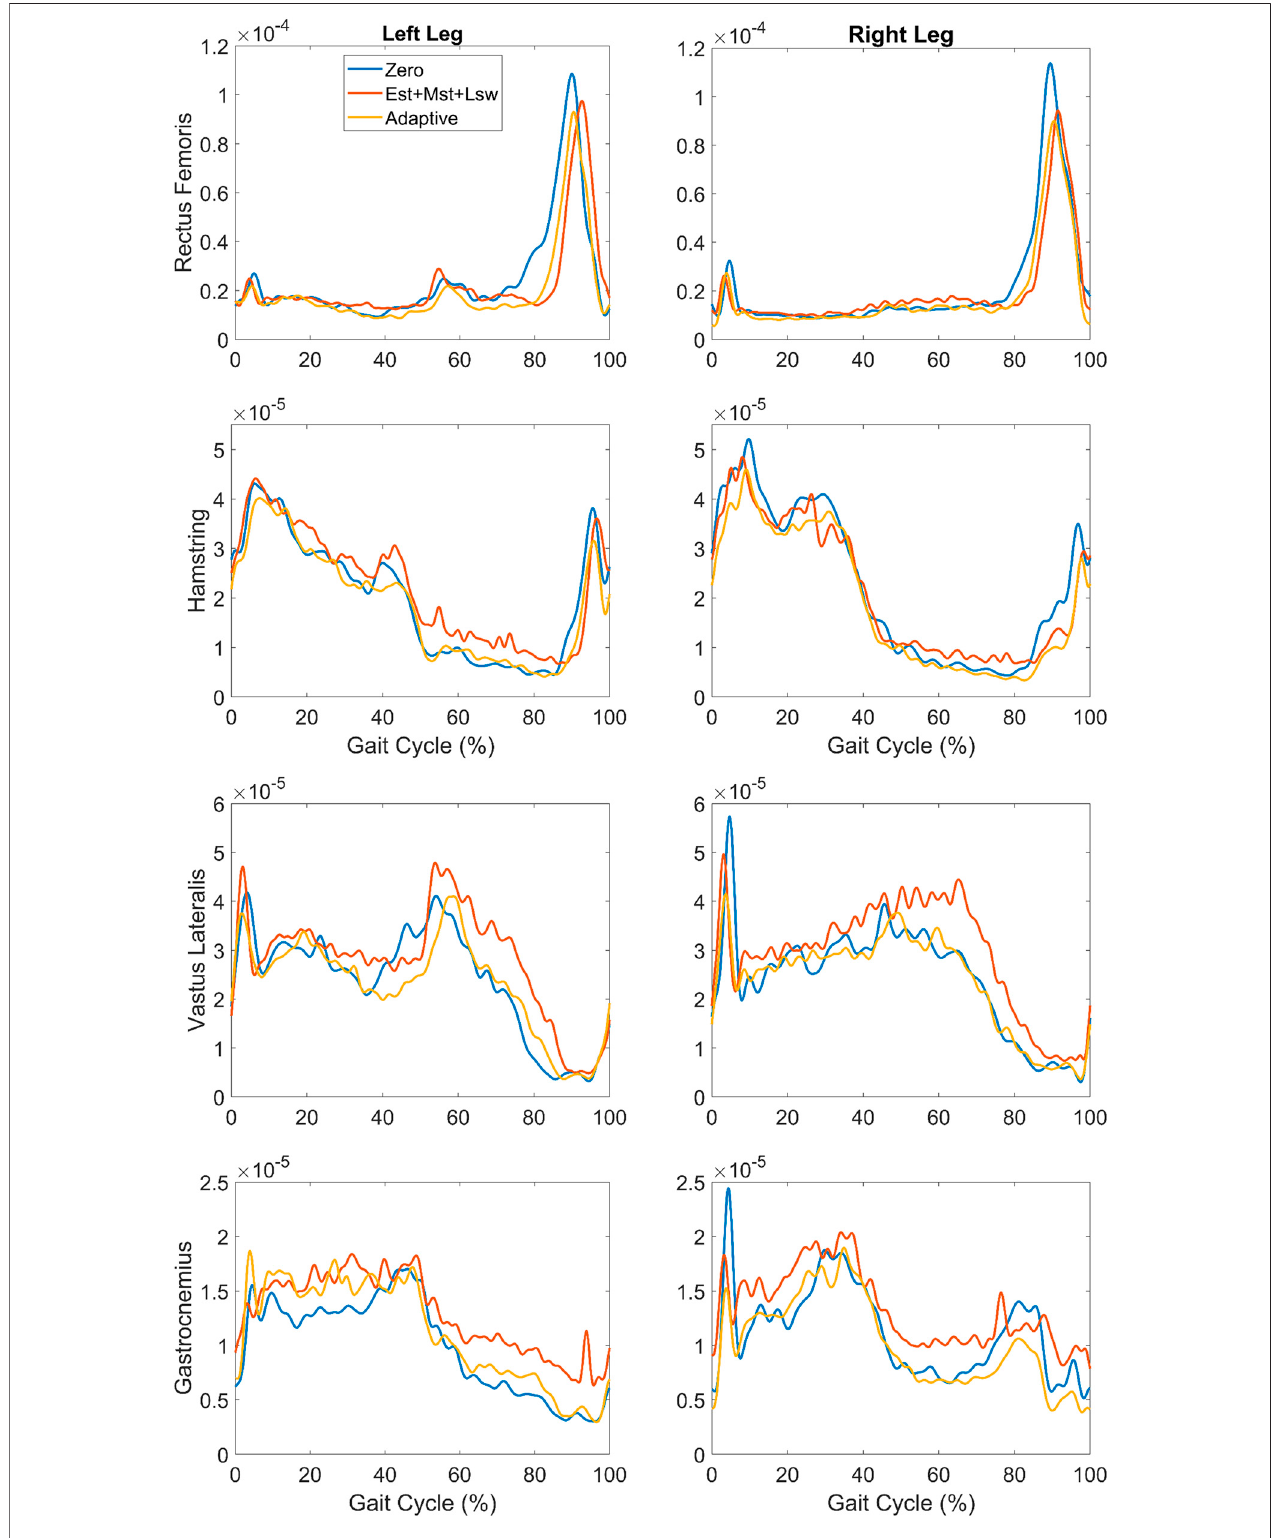
FIGURE 7 | Mean EMG linear envelopes for rectus femoris, medial hamstring, vastus lateralis and gastrocnemius plotted vs. percent gait cycle during overground walking with exoskeleton assistance provided during Est+Mst+Lsw (orange) and Adaptive (yellow) modes, as well as Zero mode with no extension assistance (blue).